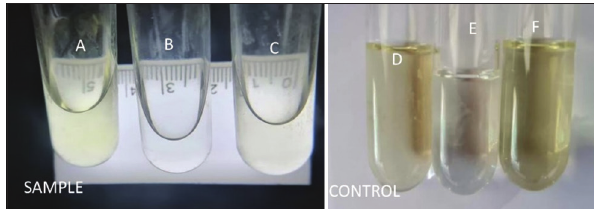
Figure-4: The quality yellow color solution of the rapid test device from the carcass (sample): (a) Intense yellow, (b) not clear, (c) weak yellow. Control: (d) weak yellow, (e) blank color, (f) intense yellow color.